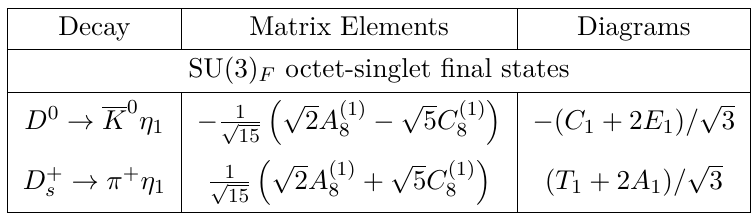
Table 7. Amplitudes for CF D → PP with octet-singlet final states using SU(3) F matrix-elements and diagrams. Overall factors containing G F and V CKM , that are identical in both representations, have been left out for